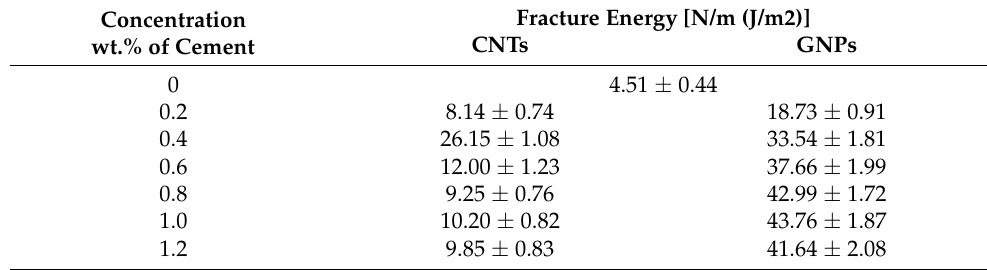
Figure 8. Average fracture energy values during flexural testing of mortars with variable nanofiller concentrations. Table 5. Values of fracture energies of mortars originating from nano